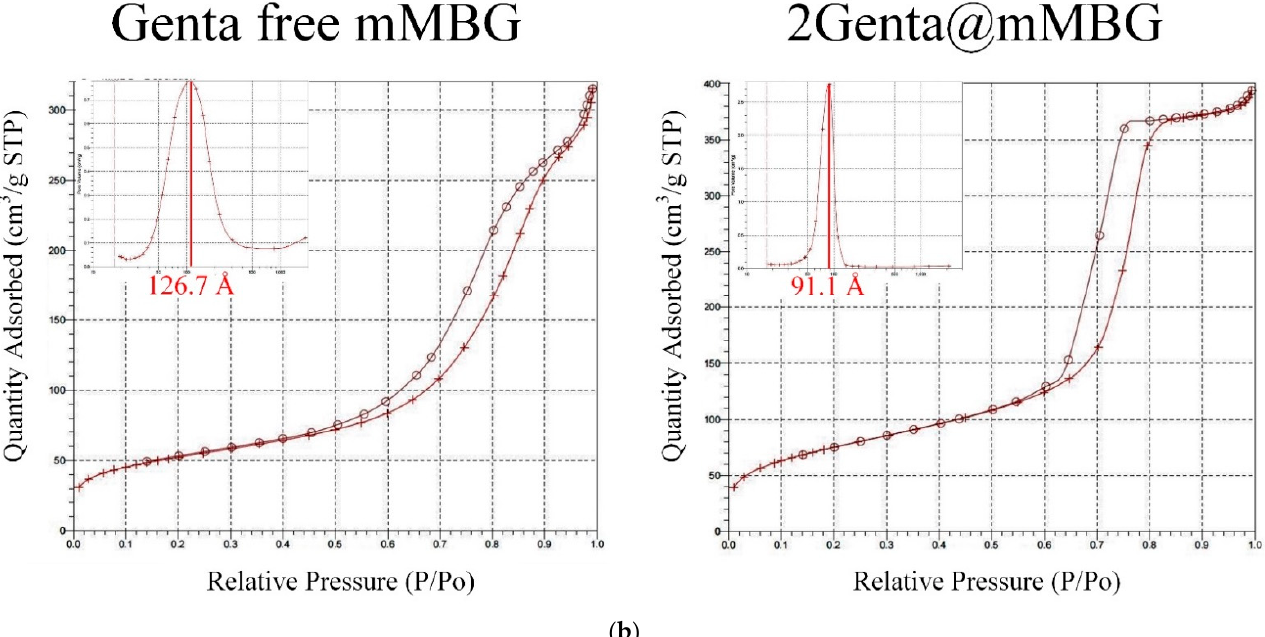
Figure 5. ( a ) SEM, TEM micrographs, and ( b ) nitrogen adsorption (+)/desorption ( o ) curves and pore size/pore volume distribution analysis diagram of Genta-free mMBG and 2Genta@mMBG. Table 2. Analysis of specific surface area, pore volume, and pore size of Genta-free mMBG and 2Genta@mMBG.